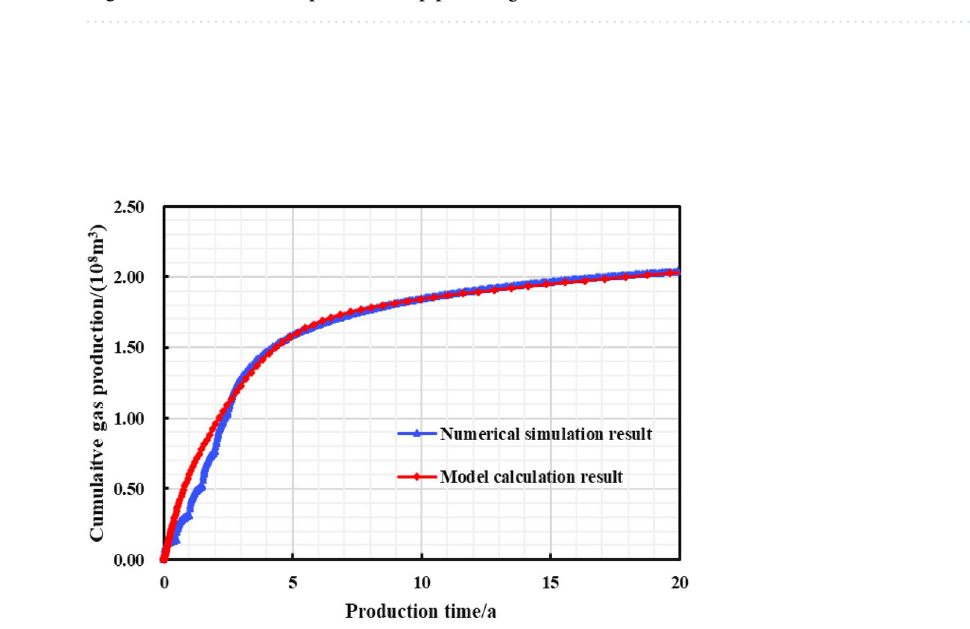
Figure 14. Model verification